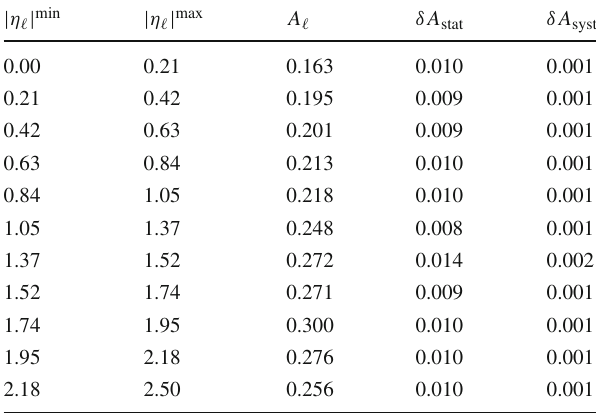
Fig. 10 Charge asymmetry for W bosons as a function of absolute decay lepton pseudorapidity, for the electron, muon and combined results. Statistical and systematic errors are shown as corresponding bars and shaded bands (not visible for most points). The lower panel shows the ratio of channels to the combined charge asymmetry in each bin. In the lower panel, error bars represent statistical uncertainties in the ratio, while the shaded band represents systematic uncertainties in the combined charge asymmetry Table 10 Charge asymmetry for W bosons as a function of absolute pseudorapidity of the decay